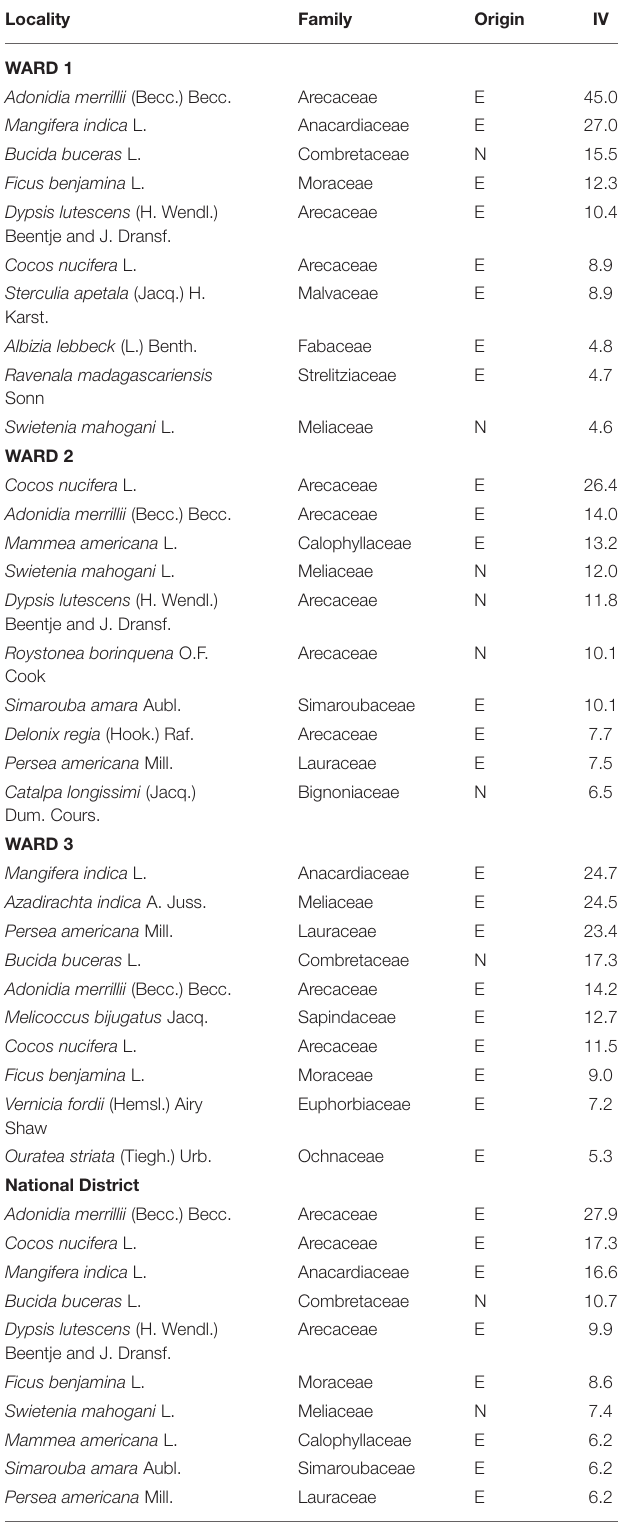
TABLE 2 | Importance values (IV) of the ten most dominant species per ward and within the National District of Santo Domingo, Dominican Republic.